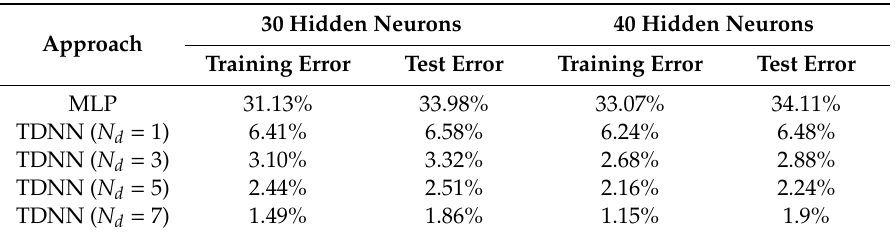
Table 6. Accuracy comparison from di ff erent training